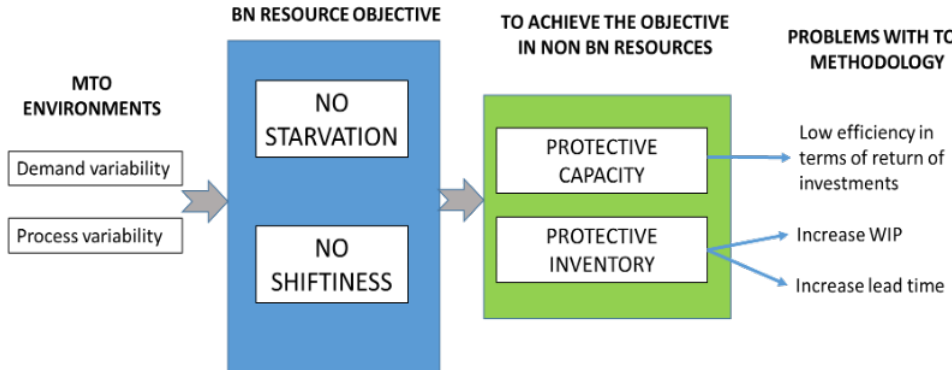
Figure 7. Dilemma between protective capacity and protective